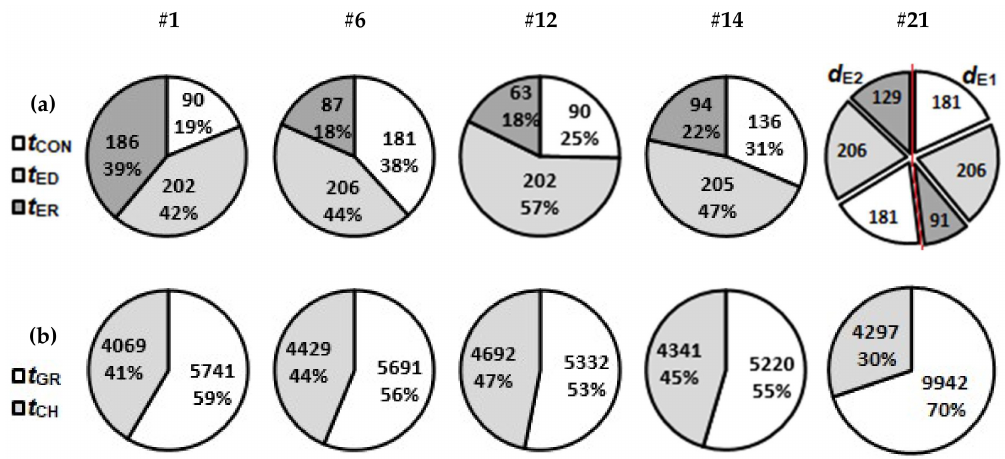
Figure 12. Time required for specific machining operation regarding denoted BGM configurations. ( a ) One groove machining times. For 2-electrode strategy (#21) groove machining times are separately presented with respect to used electrode ( d E1 = 72 µ m and d E2 = 44 µ m). ( b ) Machining time of all grooves ( t GR ) in a configuration versus corresponding channel machining time ( t CH ). Time is given in